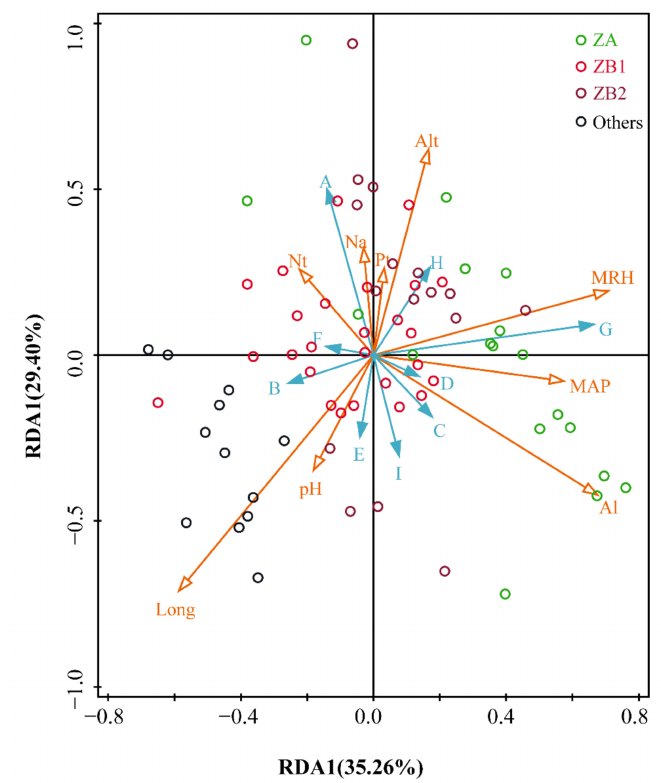
Figure 6. The relationships between environmental factors and alkylamide profiling in prickly ash